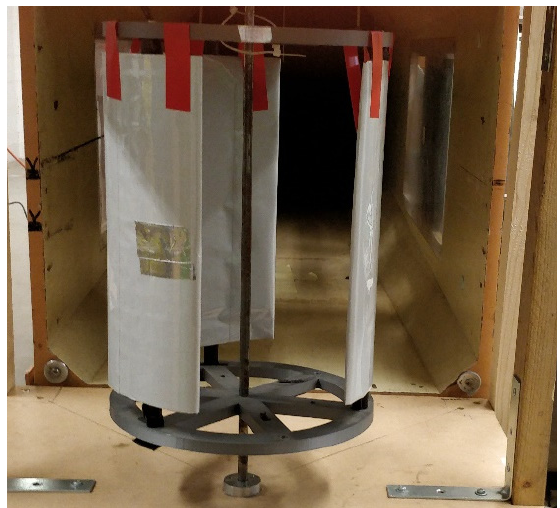
Figure 8. Vertical axis wind turbine (VAWT) in front of the wind tunnel.